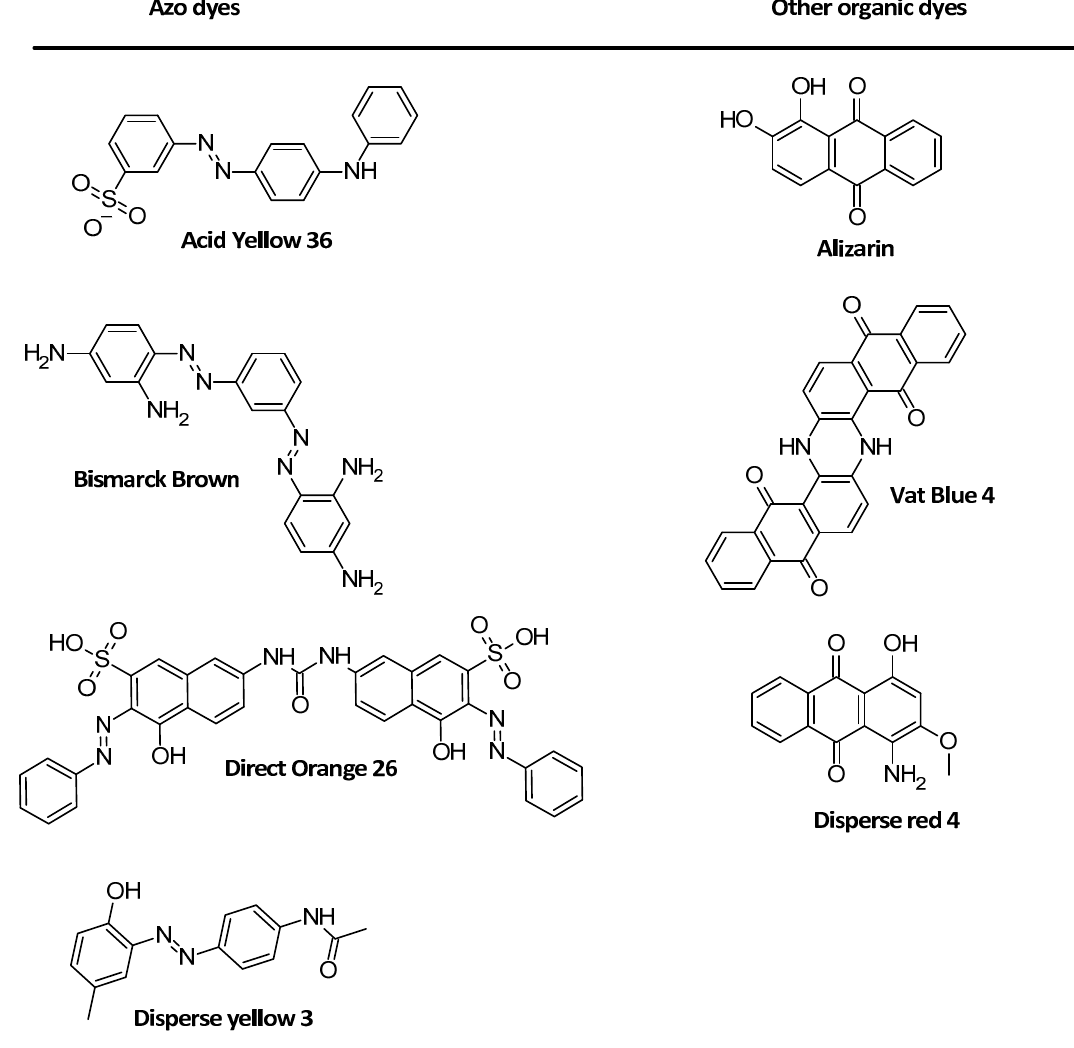
Figure 2. Examples of the most commonly used dyes in the textile domain.